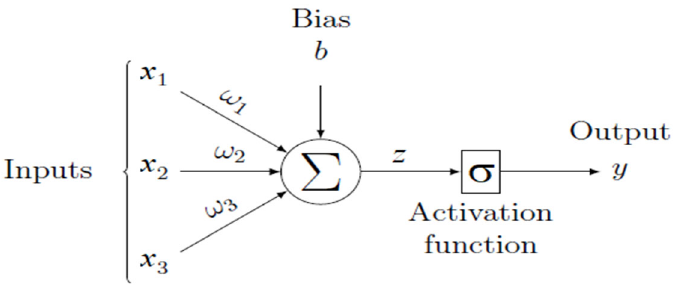
Figure 5. A Logistic Regression neural network [37], where w = ( w 1 , w 2 , w 3 ) T is a vector of weights, x = ( x 1 , x 2 , x 3 ) T is the input vector, b is the bias of the neuron, z = ∑ 𝑤 (cid:3036) 𝑥 (cid:3036)(cid:2871) (cid:3036)